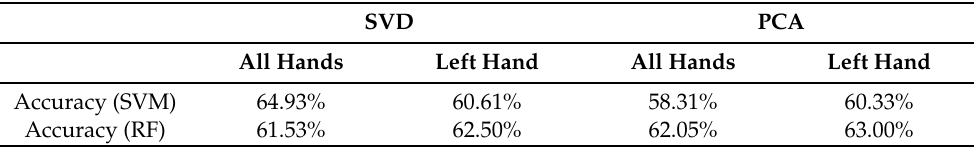
Table 5. The composite activity recognition using a set of optimal features derived from the subspace pooling technique. The features are classified with leave-one-out cross-validation. The average recognition accuracy with leave-one-out cross-validation is also presented.